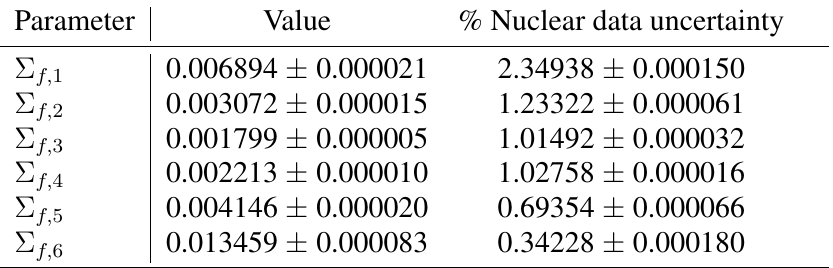
Table 2: Values computed by GPT and percentage relative standard deviations due to the uncertainties in MT18-MT102 reactions for